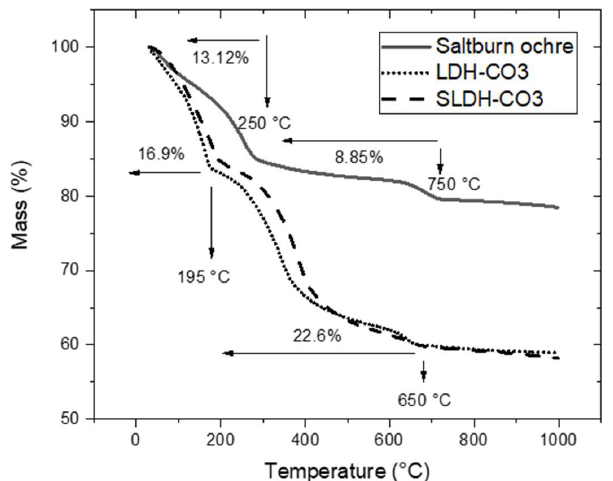
Figure 1. Thermogravimetric analysis of the Saltburn ochre and the as-synthesized ochre derived LDH-CO 3 and metal salt derived SLDH-CO 3 samples under a N 2 atmosphere.